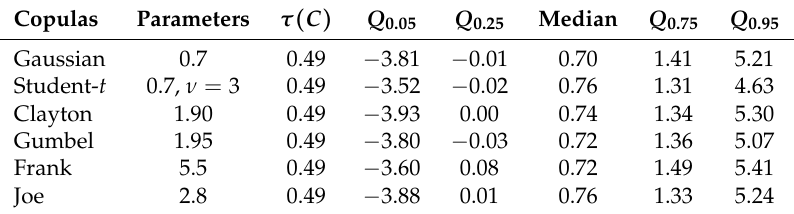
Table 13. Some percentiles of Y = X 1 / X 2 , where ( X 1 , X 2 ) modelled with six copulas having the same Kendall coefficient τ = 0.49 .